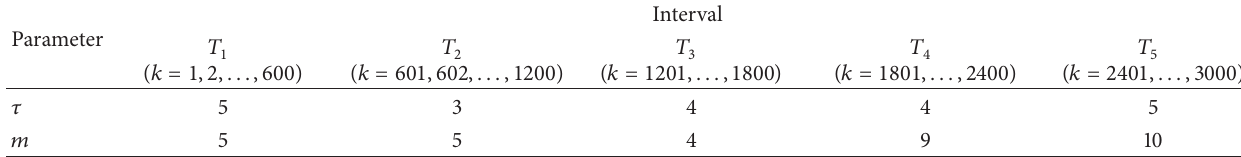
Table 3: Parameters of the same phase space reconstruction during different time periods.